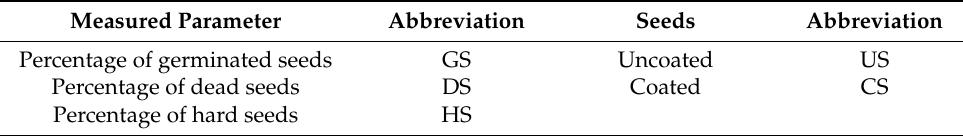
Table 5. Overview of determined parameters and abbreviations